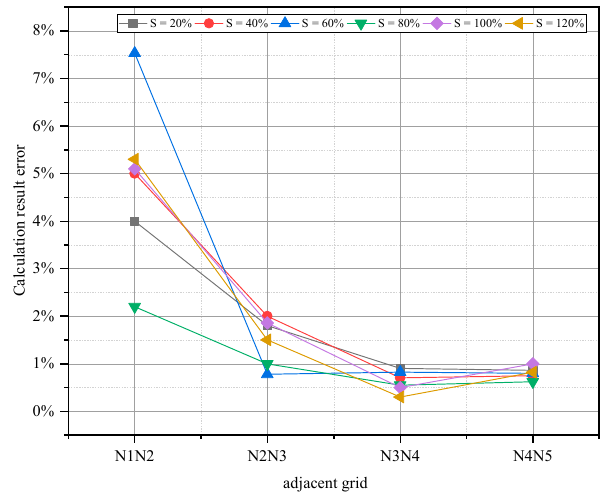
8 of 21 Figure 4. Calculated ventilation under different numbers of grids. Through the above grid-independent study, in Figure 5, it can clearly be seen that the errors of the third and fourth sets of grids for S = 20%, S = 40%, S = 80%, S = 100%, and S = 120% were 0.92%, 0.74%, 0.55%, 0.51%, and 0.33%, respectively. The error between the second set and the third set of the grid calculation results at S = 60% was 0.78%. A comprehensive analysis of the above calculations was performed, in order to ob-